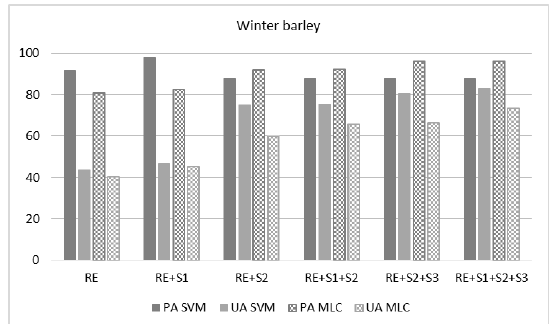
Table 2. Overall accuracies and Kappa-values for all image- combinations for SVM and MLC